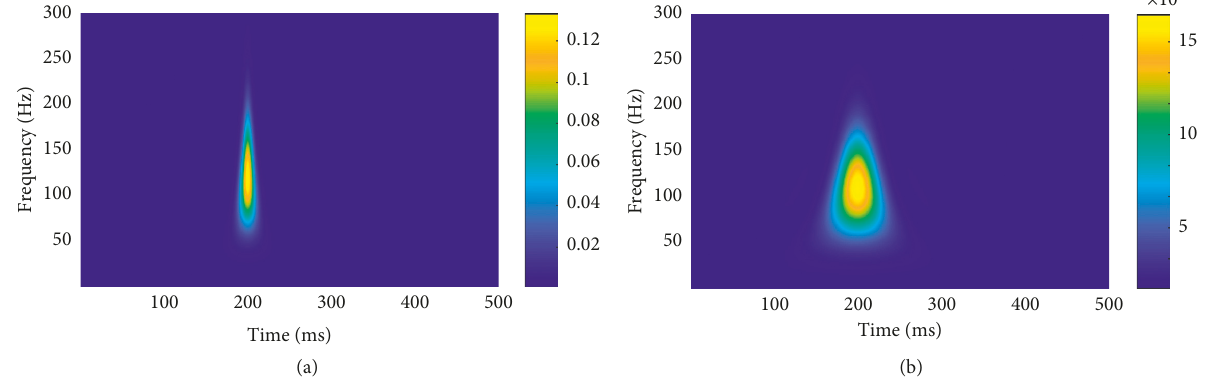
Figure 5: Time-frequency with wavelet transform. (a) Amor wavelet. (b) bump